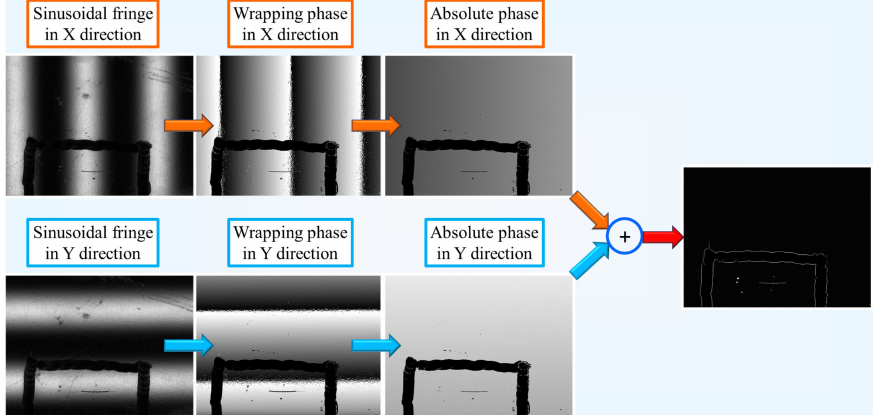
Figure 6. Transformation process of obtaining defect result.